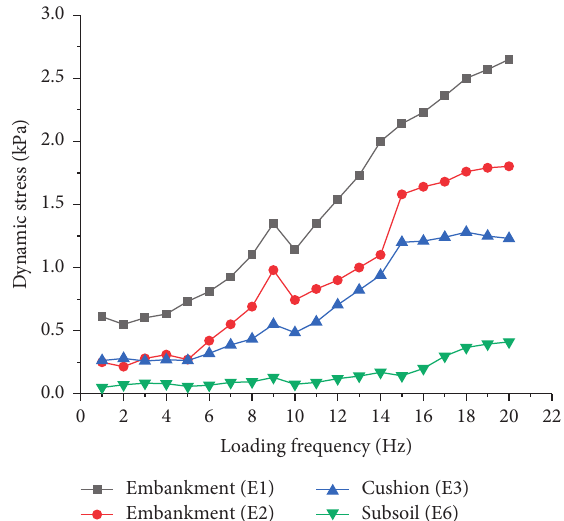
Figure 19: Frequency spectral analysis of dynamic stress at pile top and bottom for f � 20